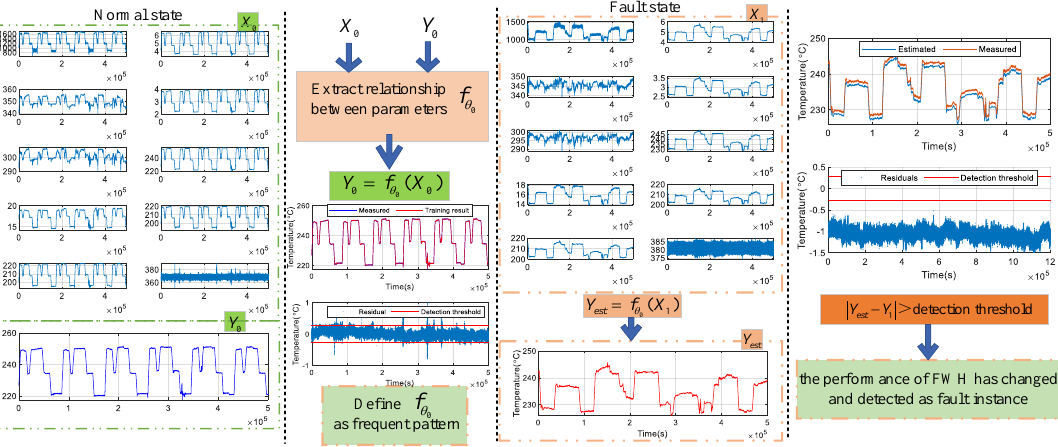
Figure 5. Diagram of proposed frequent pattern model-based method.